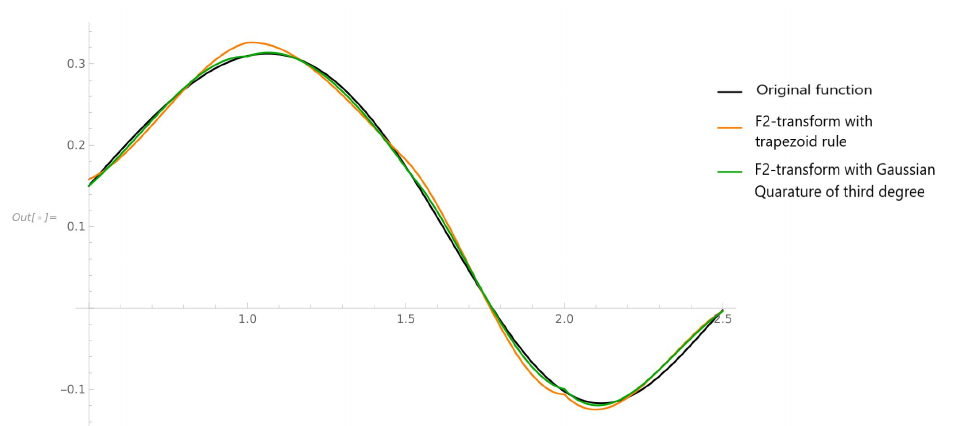
Figure 1. Original function f ( x ) = sin x 2 and its two inverse F 2 -transforms whose components were e x calculated using the trapezoid rule and the here proposed 3-point Gaussian quadrature rule.